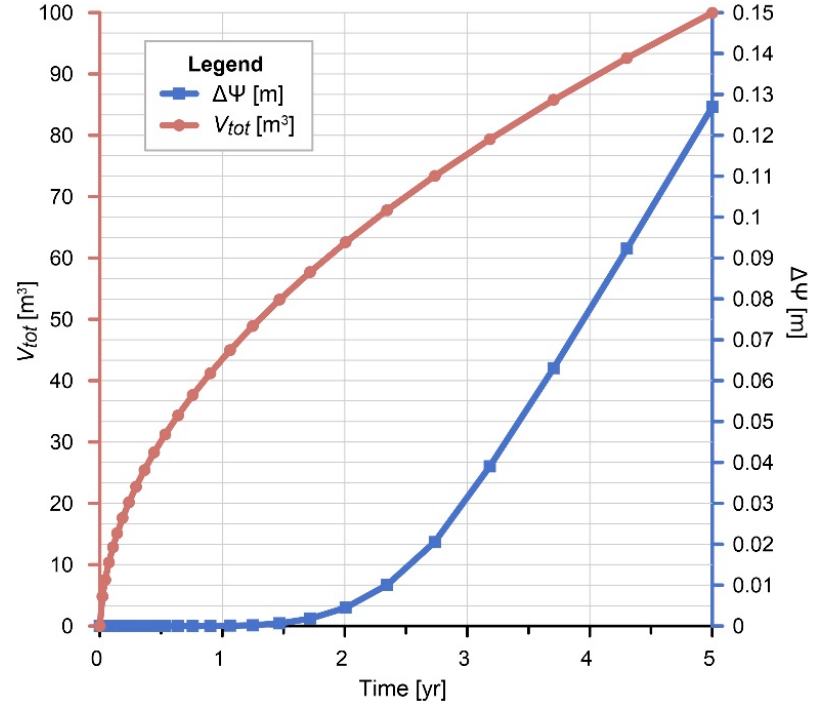
Figure 2. Water level increase ( ∆Ψ ) and cumulative water volume ( V tot ) in time (SG-1, ∆ z = 0 m, ∆ h = 0 m).